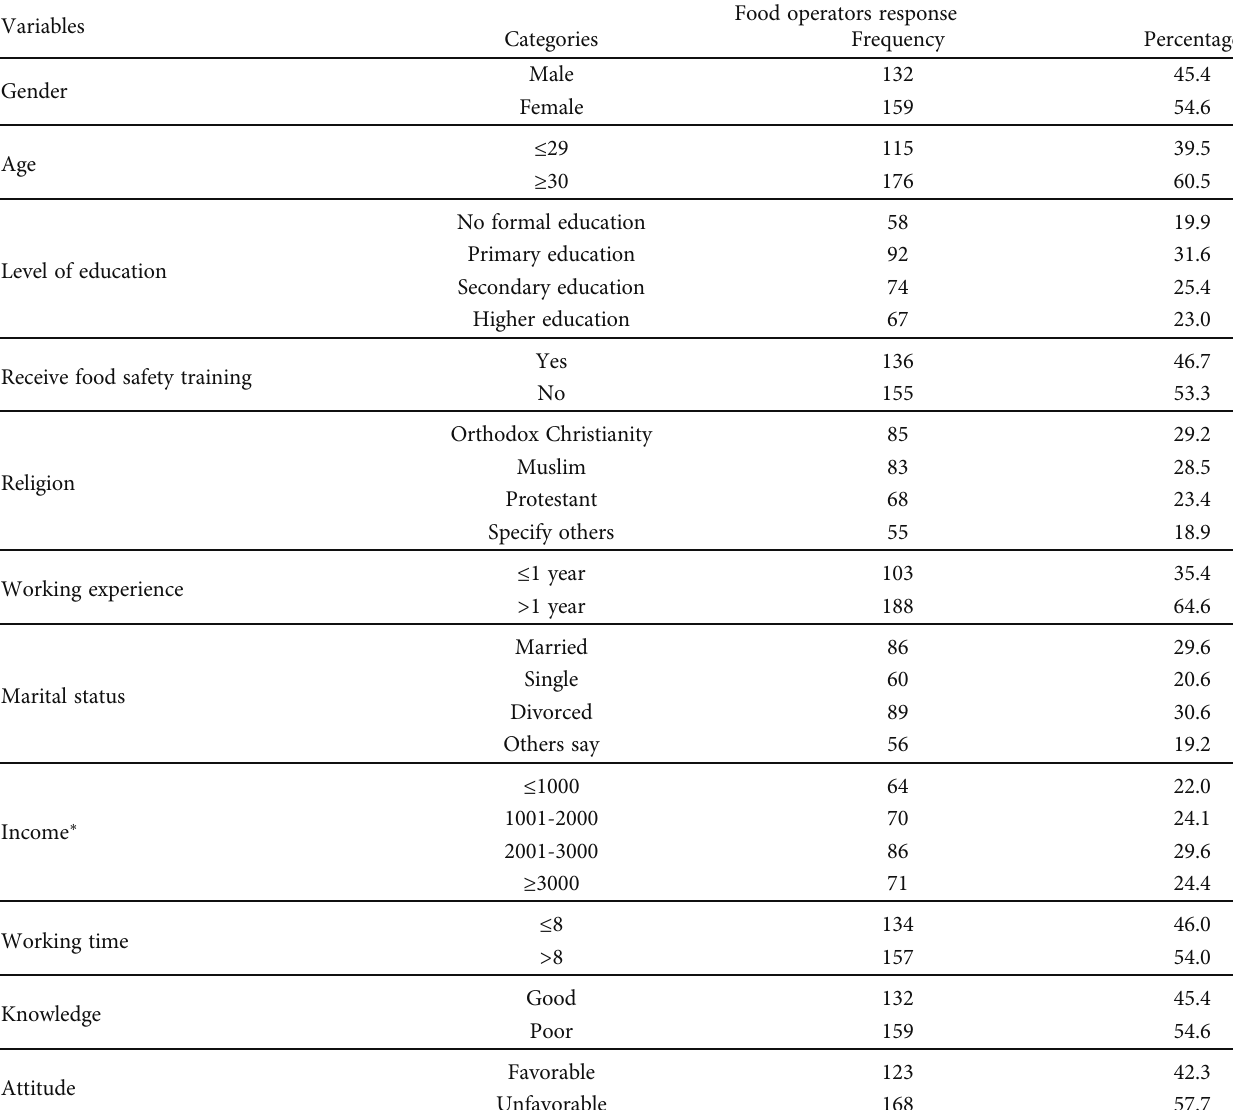
Table 1: Sociodemographic characteristics of food workers working at the Woldia University canteen, May-July 2021, ( n = 291 ).